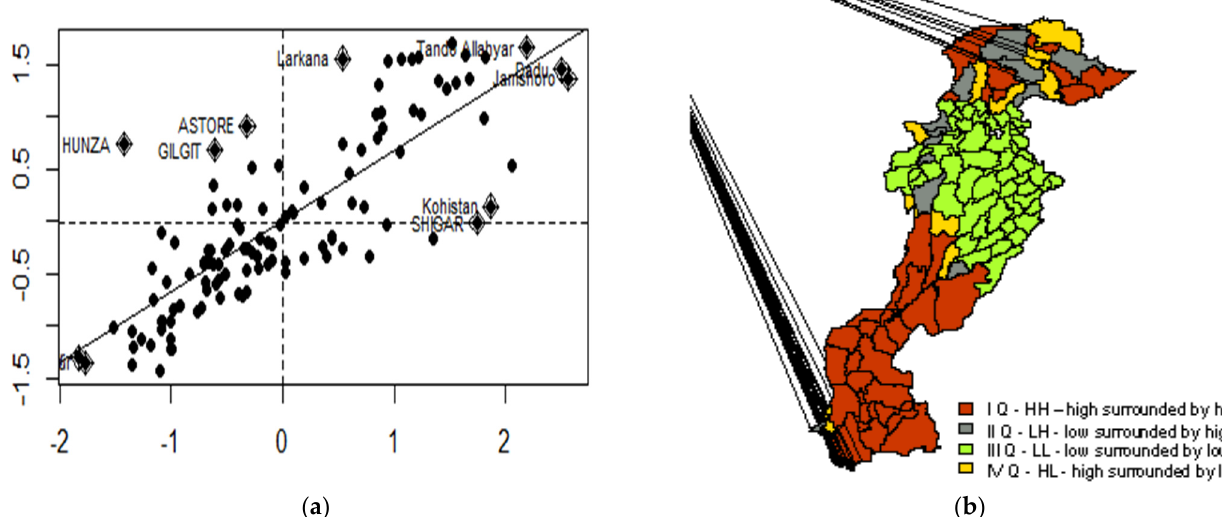
Figure 6. Childhood stunting in districts compared to the situation in their neighbouring regions: ( a ) Moran scatterplot; ( b ) mapped values of Moran scatterplot.